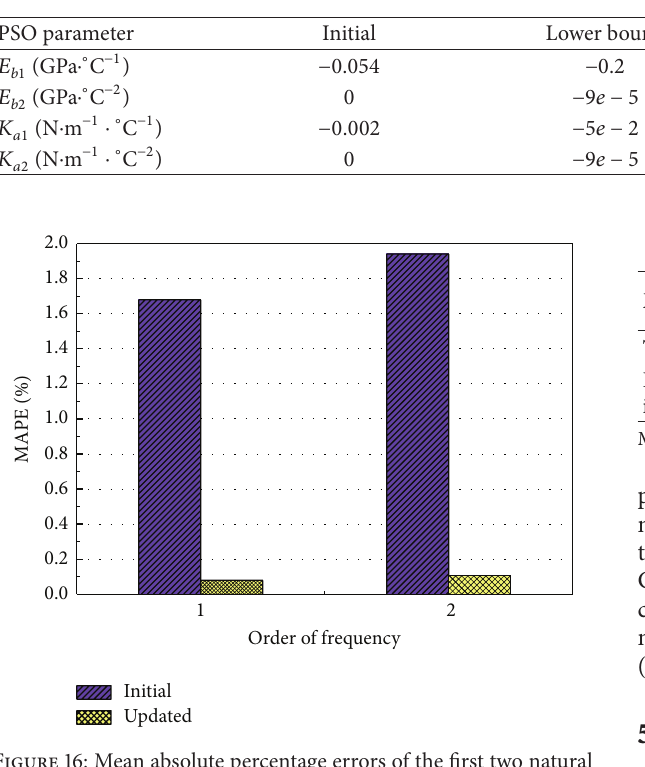
Table 6: Particle swarm optimization parameters.